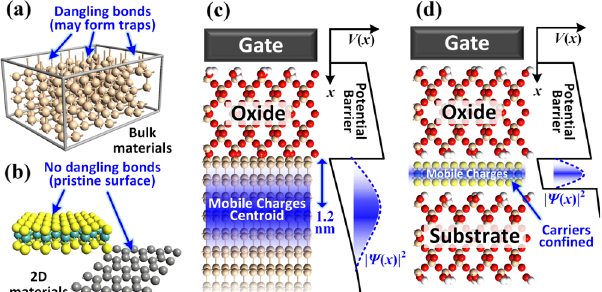
FIG. 1. Schematic illustrating advantages of 2D materials: surfaces of (a) 3D (bulk) and (b) 2D materials. The pristine interfaces (without out-of-plane dangling bonds) of 2D materials help reduce the interface traps. Mobile charge distribution in (c) 3D and (d) 2D crystals used as channel materials. V ð x Þ and j ψ ð x Þj 2 represent the potential and the probability density of the electronic charges, respectively. The carrier confinement effect in 2D materials leads to excellent gate electrostatics.